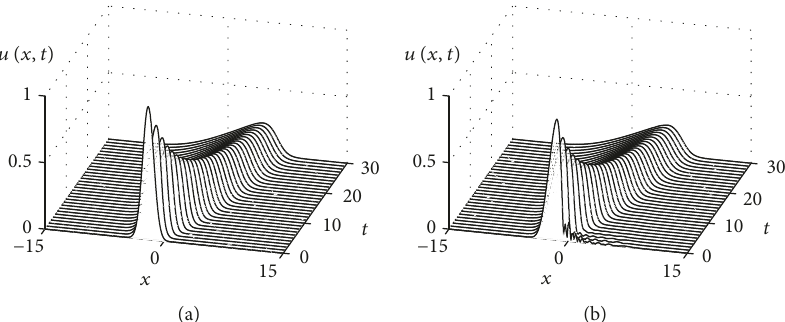
Figure 2: (a) Evolution dynamics of Burgers ’ equation with initial condition u x , 0 = exp − x + 2 2 . (b) Fifteen mode DMD approximation of the Burgers ’ evolution. The simulation of (24) was performed over t ∈ 0, 30 where the sampling was taken at every Δ t = 1 . The domain was discretized with n = 256 points on a domain x ∈ − 15, 15